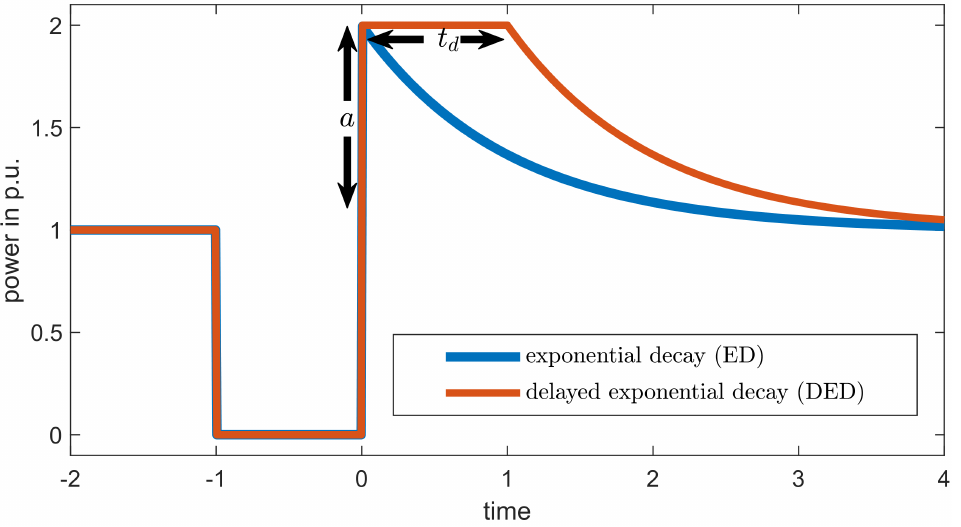
Figure 1. Exponential decay of CLPU with and without delay, a = 1 and τ = 1, t d = 0 or t d = 1,